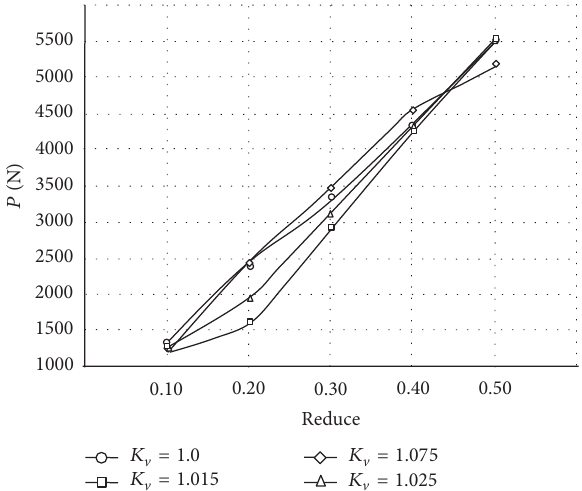
Figure 7: The calculated distributions of forces on the roller electrode, depending on the reduce and the speed asymmetry coefficient (the initial thickness of the compact material is 0.5